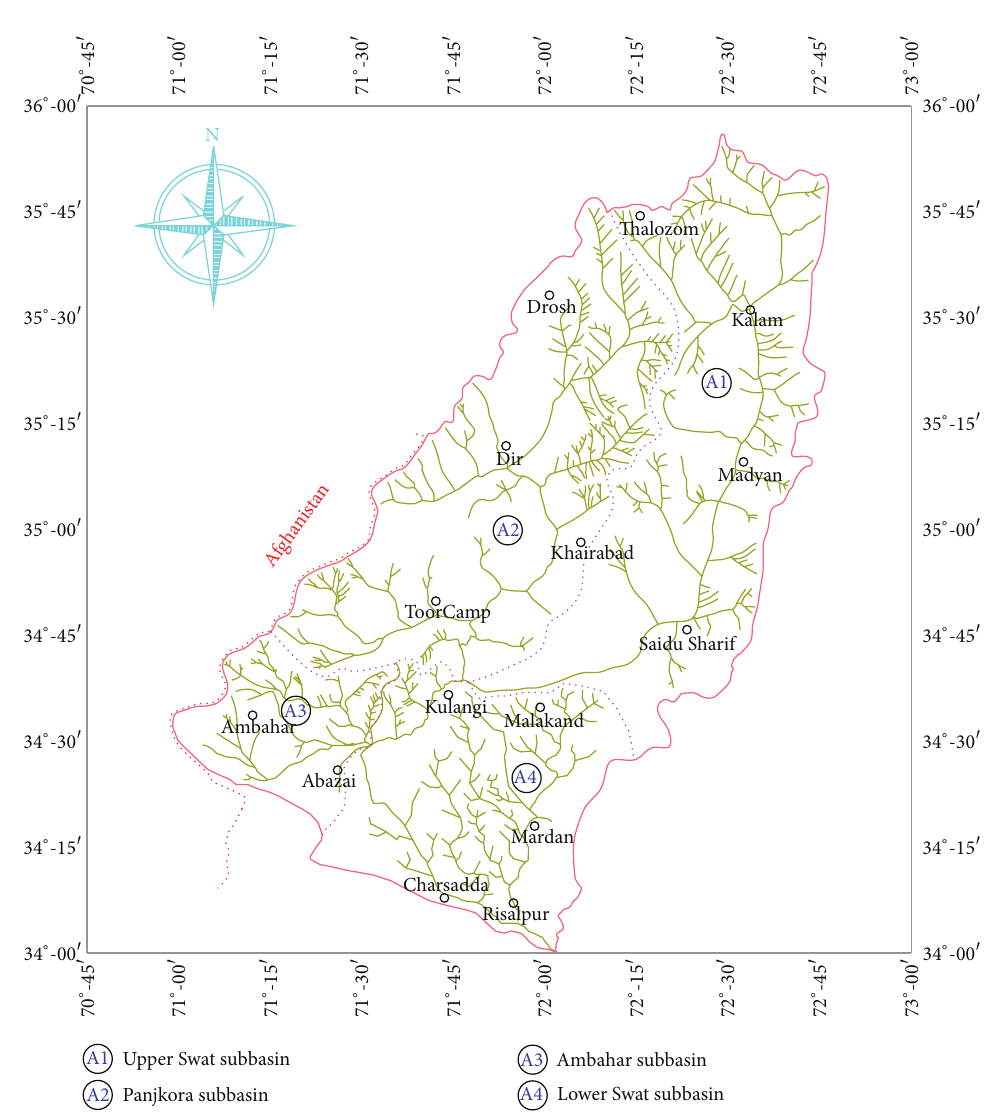
Figure 1: Locations of meteorological stations at Swat River